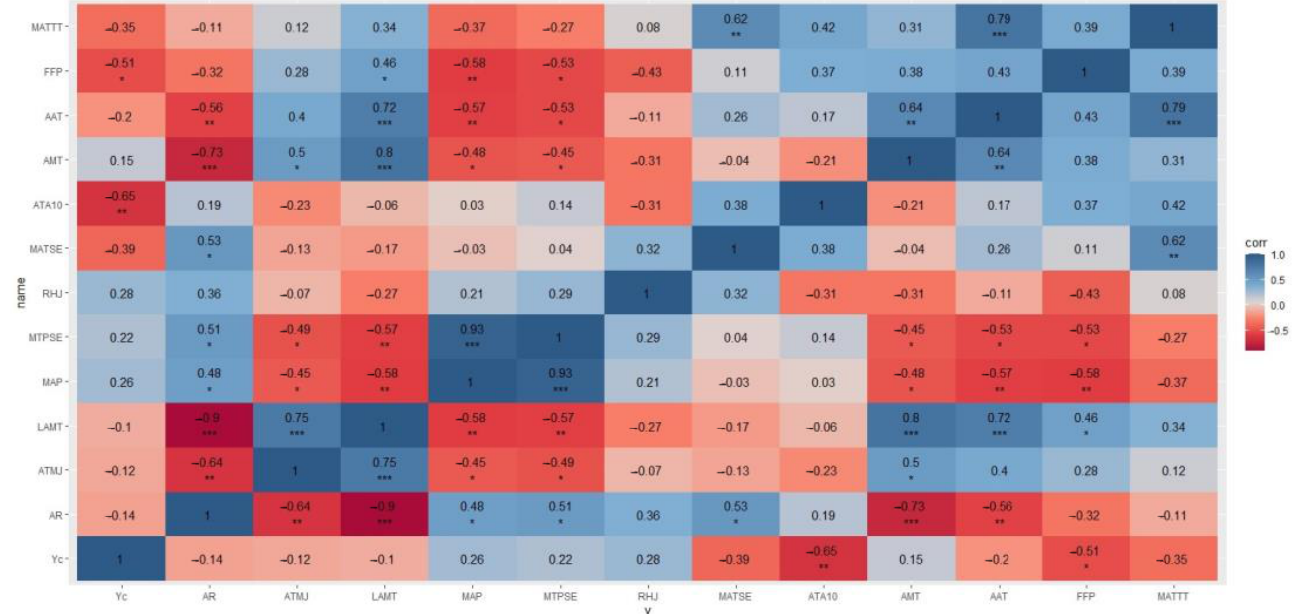
Figure 4. Correlation coefficient matrix heatmap and significance analysis of twelve meteorological factors and yield ( *: p < 0.05 **: p < 0.01 ***: p < 0.001 ).